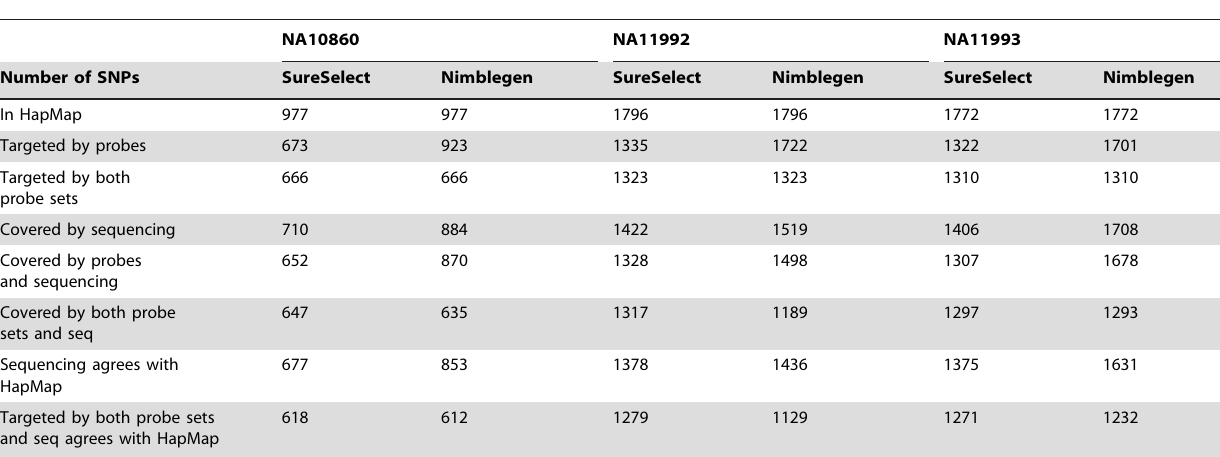
Table 3. HapMap SNPs in the targeted region for the three individuals sequenced.